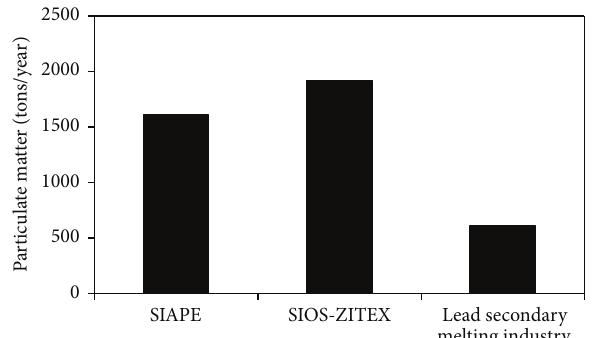
Figure 2: Annual fluxes of particulate emissions from the main pollutant sources